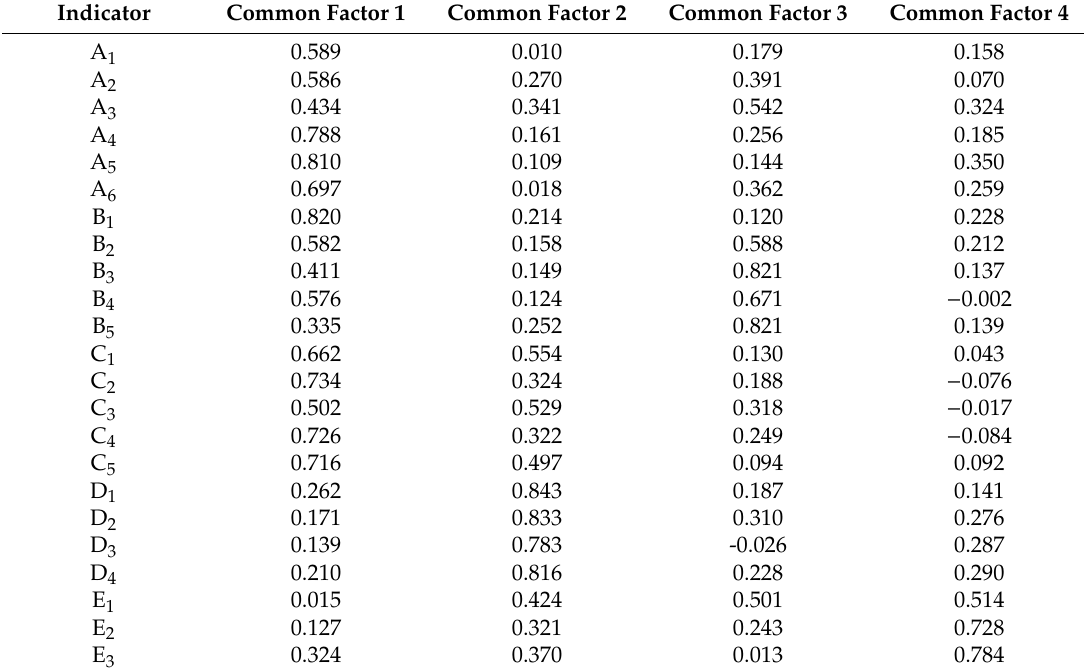
Table 8. Rotating posterior factor load matrix.